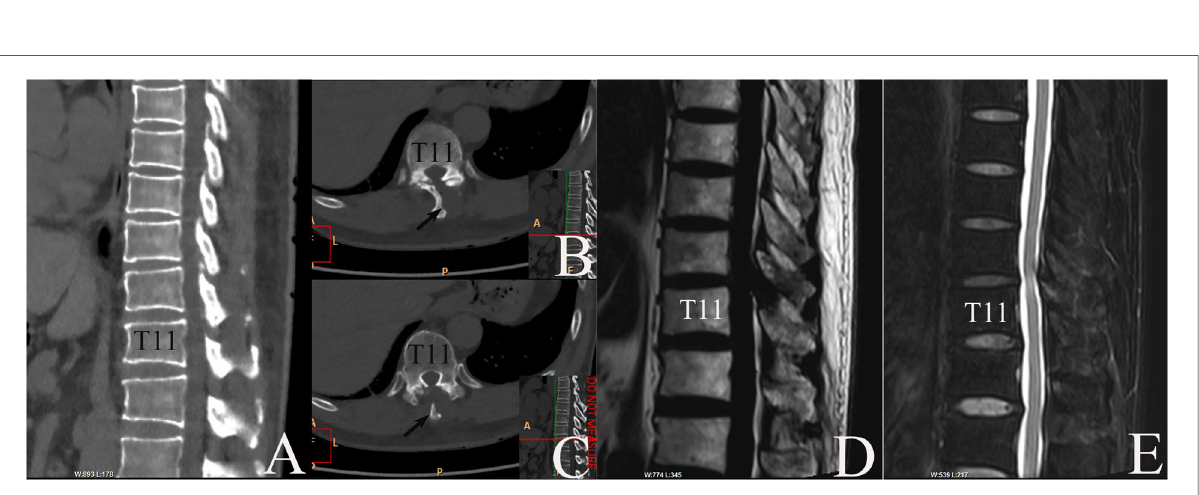
FIGURE 3 MR and CT re-examinations postoperatively. ( A – C ) CT taken on 15 May 2019 con fi rmed disappearance of CLF and fenestration at left T10 – 11 interlaminar space. ( A ) Midsagittal plane, bone window. ( B, C ) Axial plane, bone window. Arrow: T10 spinal process. ( D, E ) MRI taken on